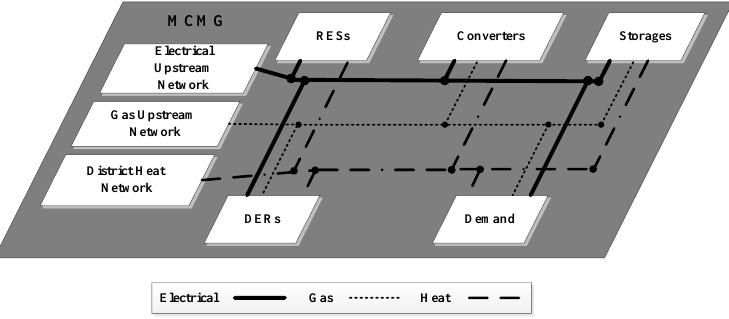
Figure 1. Multi-carrier microgrid (MCMG) structure.